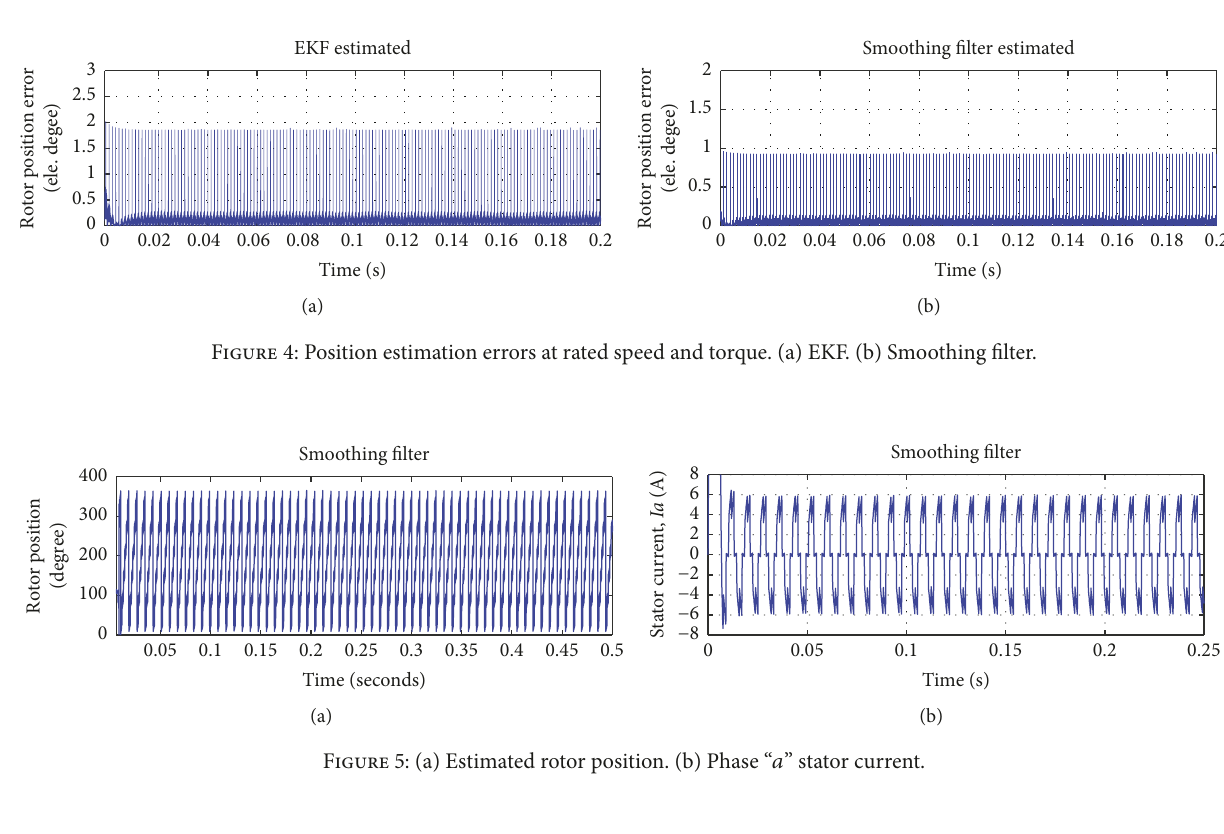
Figure 5: (a) Estimated rotor position. (b) Phase “ 𝑎 ” stator current.